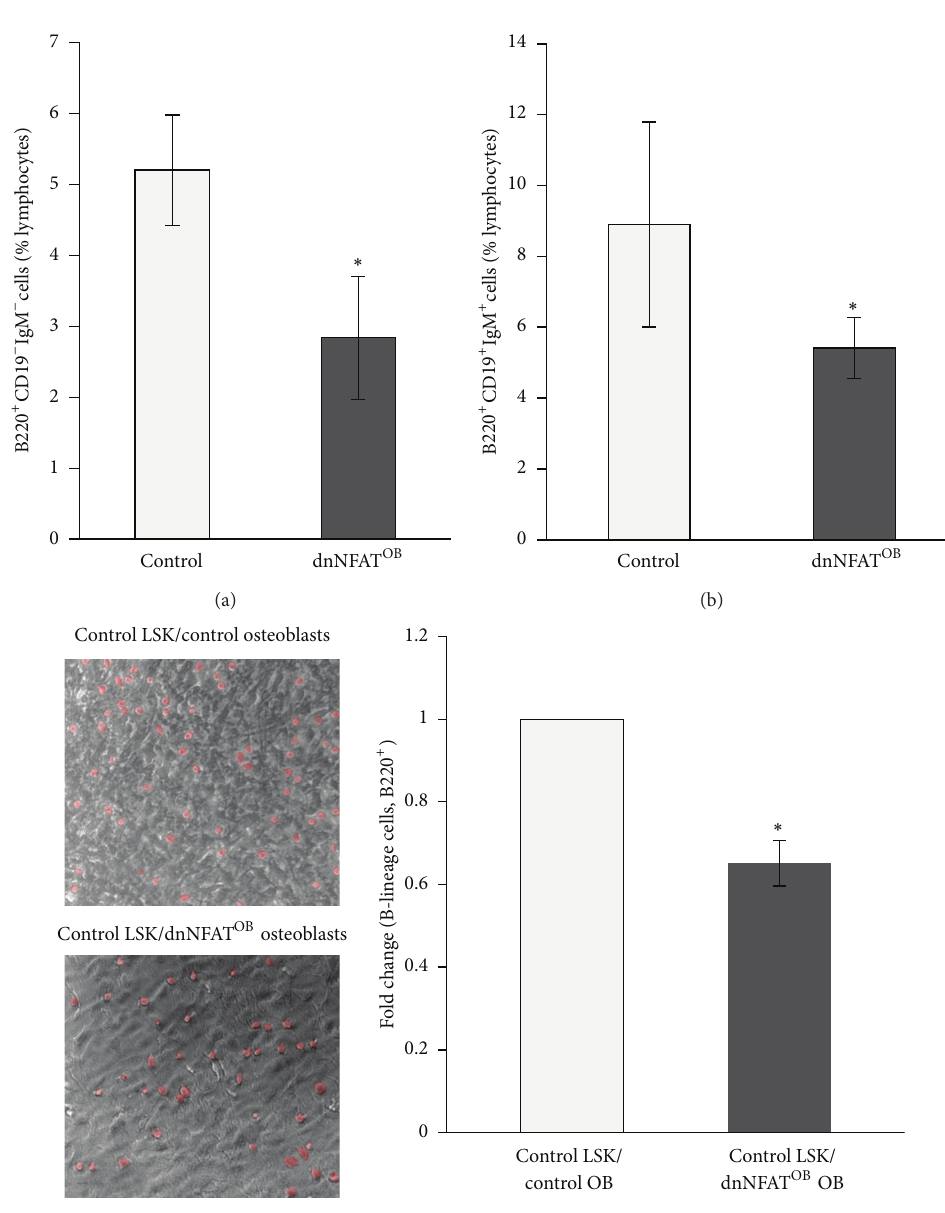
Figure 4: B-cell differentiation is decreased by the inhibition of NFAT signaling in osteoblasts. (a-b) Bone marrow was flushed from tibiae and femora of 12-week-old control and dnNFAT OB mice and analyzed by flow cytometry to examine B-cell development. Percentages of B-lineage cells were determined for control ( 𝑛 = 5 ) and dnNFAT OB ( 𝑛 = 3 ) mice from the gated lymphocyte population. (a) B220 + CD19 − IgM − (b) B220 + CD19 + IgM + . Mean indicated by black bar. (c-d) Primary osteoblasts were harvested from calvariae of 1-day-old control and dnNFAT OB mice and cultured for 14 days in the presence of 𝛽 -glycerophosphate and ascorbic acid-2-phosphate to induce osteoblast differentiation. Bone marrowwasflushedfrom12-week-oldcontrolmice,andLSKcellsweresortedbyflowcytometry,seededondifferentiatedprimaryosteoblasts, and cocultured for 14 days. At the end of the culture, osteoblasts and hematopoietic cells were trypsinized and analyzed by flow cytometry for the B220 cell marker. (c) Representative phase-contrast images show hematopoietic cells ( indicated by red pseudocolor ) cocultured on primary osteoblasts. (d) B220 + B-lineage cells were analyzed by flow cytometry after coculture of LSK cells on control and dnNFAT OB differentiated primary osteoblasts. Values, obtained from three independent experiments performed in duplicate, represent the mean ± SD; ∗ 𝑃 < 0.05 compared to